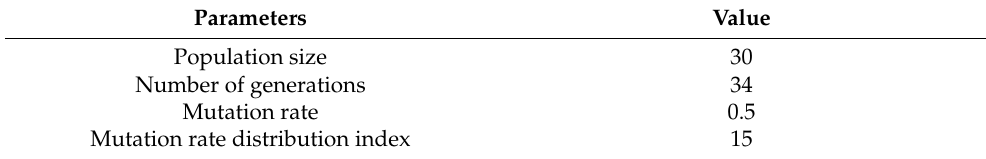
Table 2. Recommended settings of the Genetic Algorithm in the Advanced Direct Optimizer (ADO).